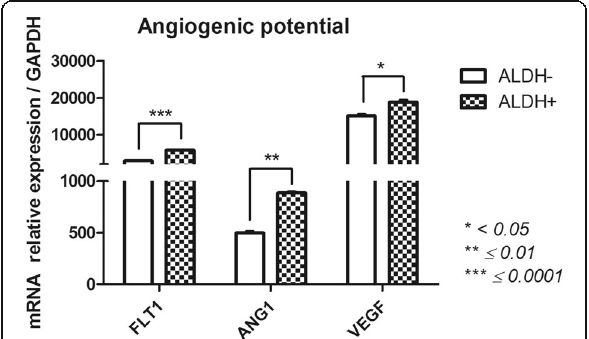
Fig. 7 Angiogenesis-related gene expression profile of FSK-MSC subsets according to ALDH activity. After flow cytometry sorting of ALDH+ and ALDH- FSK-MSC subsets, we investigated by qPCR the expression profiles of angiogenesis-associated genes FLT1, ANG1 and VEGF . Data are presented as mean ± SEM of mRNA gene expression relative to GAPDH expression